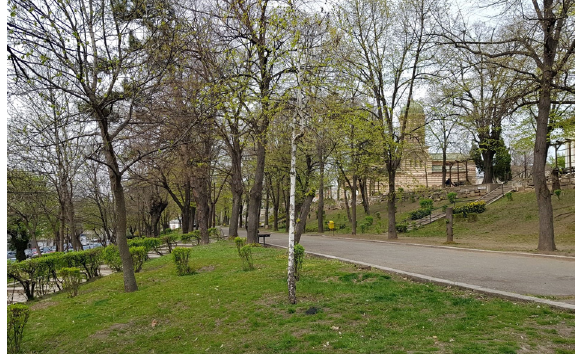
Fig. 6. The former Valley of 7 Wells , April 2019.